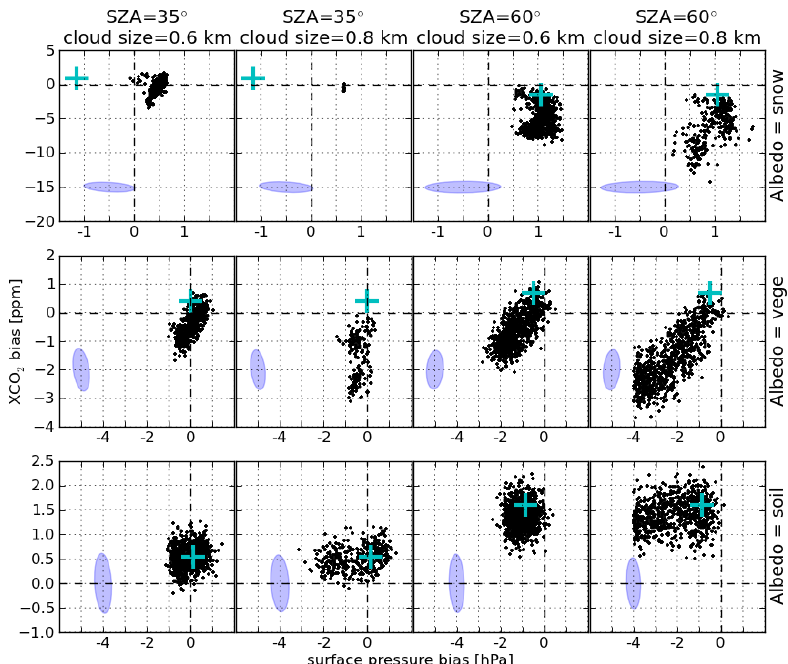
Figure 13. Summary of surface pressure and X CO retrieval bias and covariance for all scenarios with 0.6 and 0.8km clouds. Plot panels are 2 arranged in the same order as Fig. 8. In each panel, the screened retrievals are shown (black points) along with the mean clear sky retrieval (large cyan cross). The ellipse shows the 1 σ posterior covariance for these two retrieved variables, offset by an arbitrary amount for display clarity.